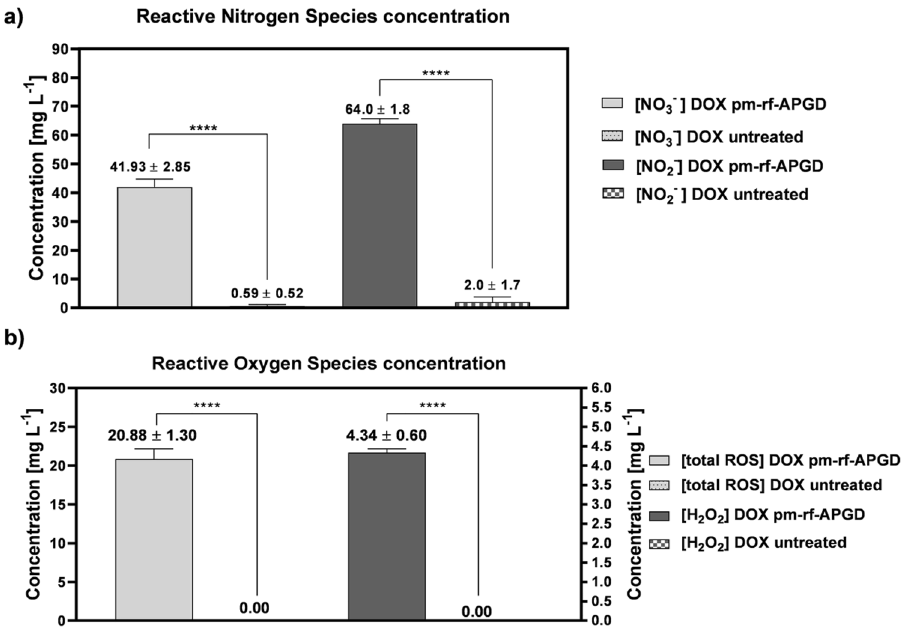
Figure 5. The concentration of reactive nitrogen ( a ) and oxygen ( b ) species determined in the pm-rf-APGD- treated DOX solution in addition to the untreated DOX solution. Means ± standard errors of the measured concentrations of the reactive forms are given. Asterisks mark: statistically significant differences (one-way analysis of variance with the Tukey’s post-hoc test; **** p <